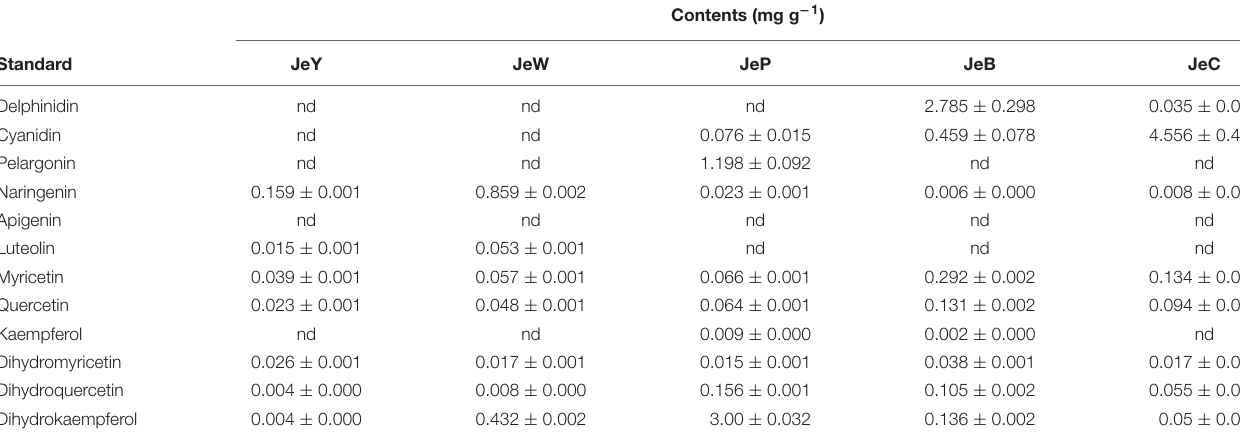
TABLE 3 | The contents of flavonoids in flower petals of S. cruentus